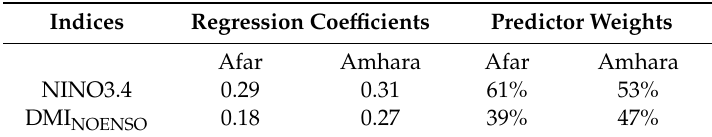
Figure 7. Standardized modeled Kiremt rainfall (NINO3.4 + DMI NOENSO ) and observed regional rainfall for the same period for ( a ) Amhara and ( b ) Afar regions. NINO3.4-based modeled rainfall with observed regional rainfall for 1966–2006 for ( c ) Amhara and ( d ) Afar regions. Table 2. Regression coefficients for prediction of normalized regional Kiremt rainfall from normalized predictor indices, and the relative weights of each predictor index on the regional Kiremt rainfall model estimates.